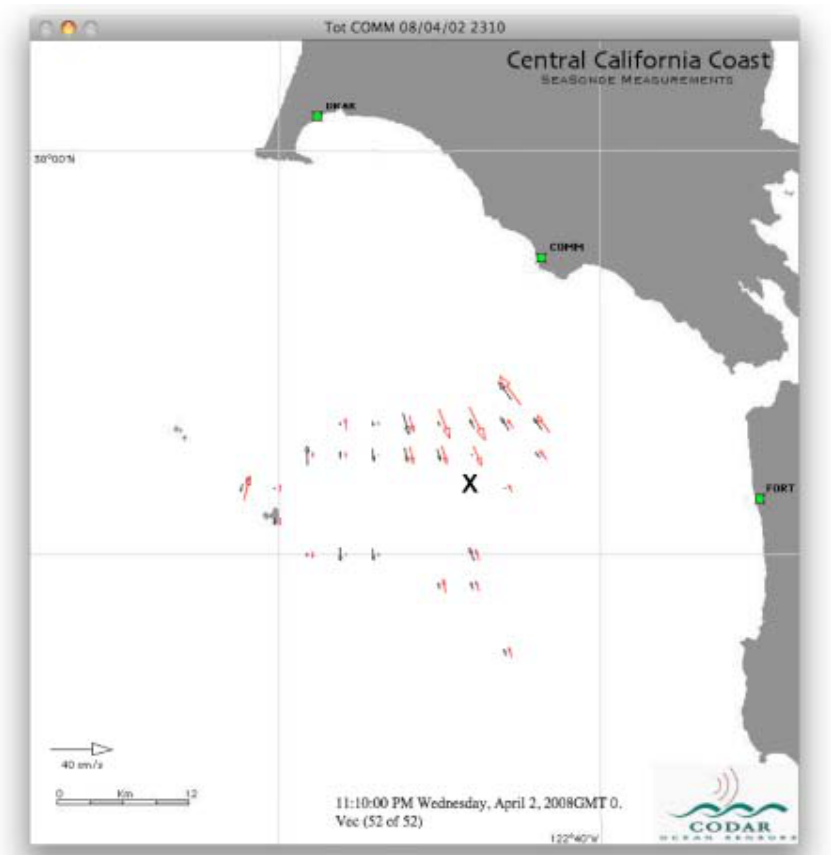
Figure 15. A comparison map of radial velocities. Black—calculated from total velocity vectors produced by COMM, FORT; Red—measured by DRAK. Time series of radial velocities at the point shown marked X are plotted in Figure